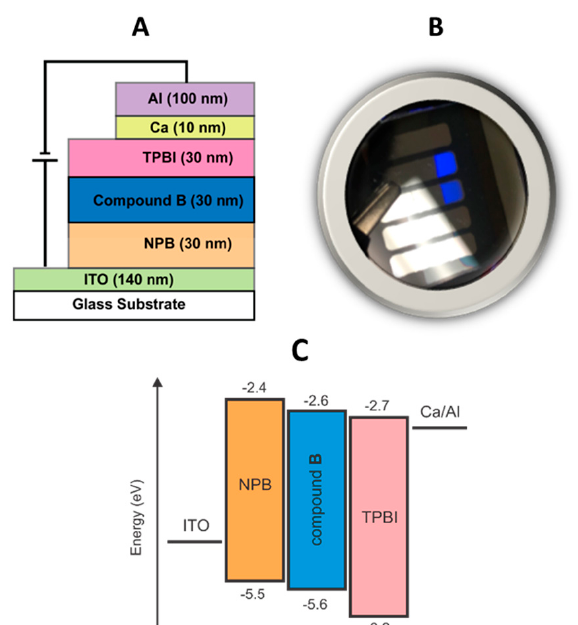
Figure 6. Structure of the OLED prototype ( A ), a photograph of an actual OLED showing blue emission at an applied voltage of 3 V ( B ), and the device energy diagram ( C ).